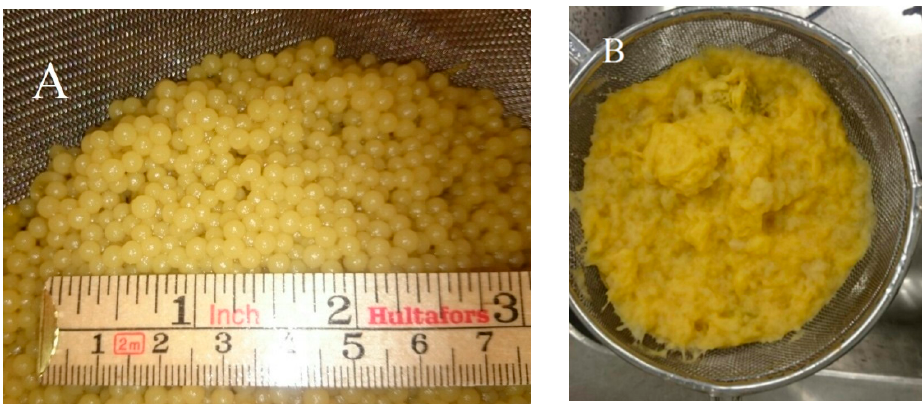
Figure 6. ( A ) Pellet type growth by R. oryzae and ( B ) mycelial type growth by M. indicus in airlift bioreactor on CWFS without any nutrients supplementation. The photos are taken after 72 and 48 h cultivation, respectively.